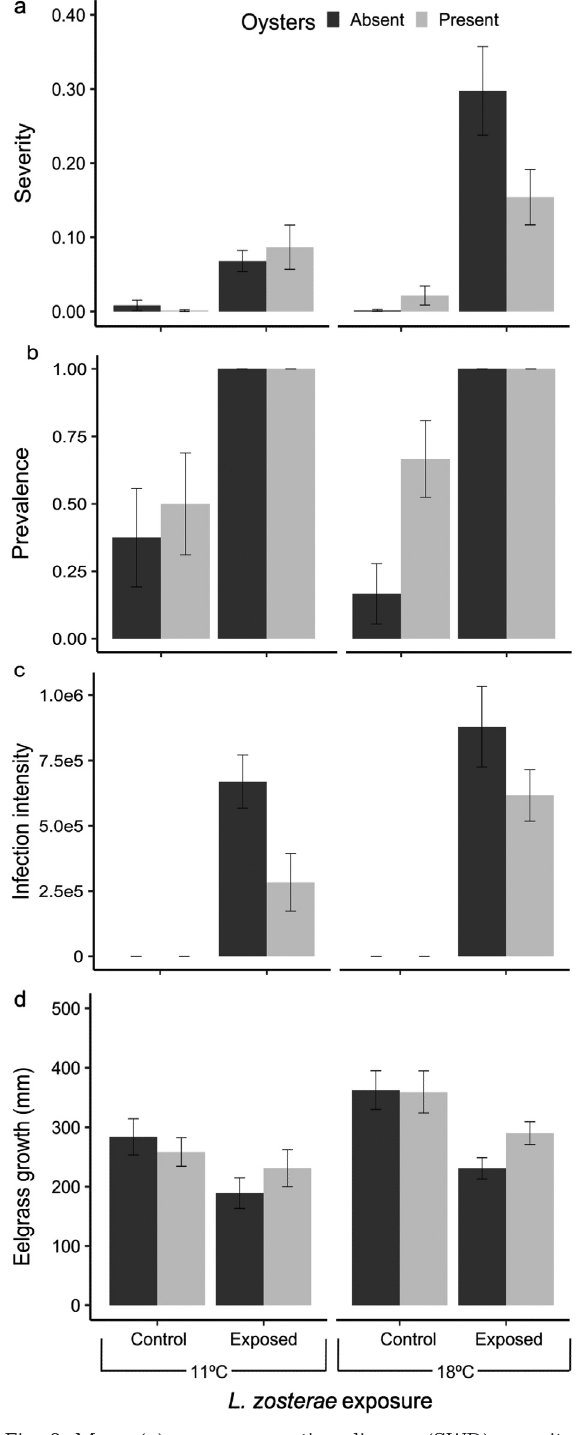
Fig. 2. Mean (a) seagrass wasting disease (SWD) severity, (b) prevalence of lesions, (c) infection intensity (copies of L. zosterae DNA per mg of eelgrass tissue) and (d) eelgrass growth (total new growth) of eelgrass ramets either ex- posed or not exposed (control) to L. zosterae in the presence or absence of oysters at 11°C or 18°C. Error bars represent ±1